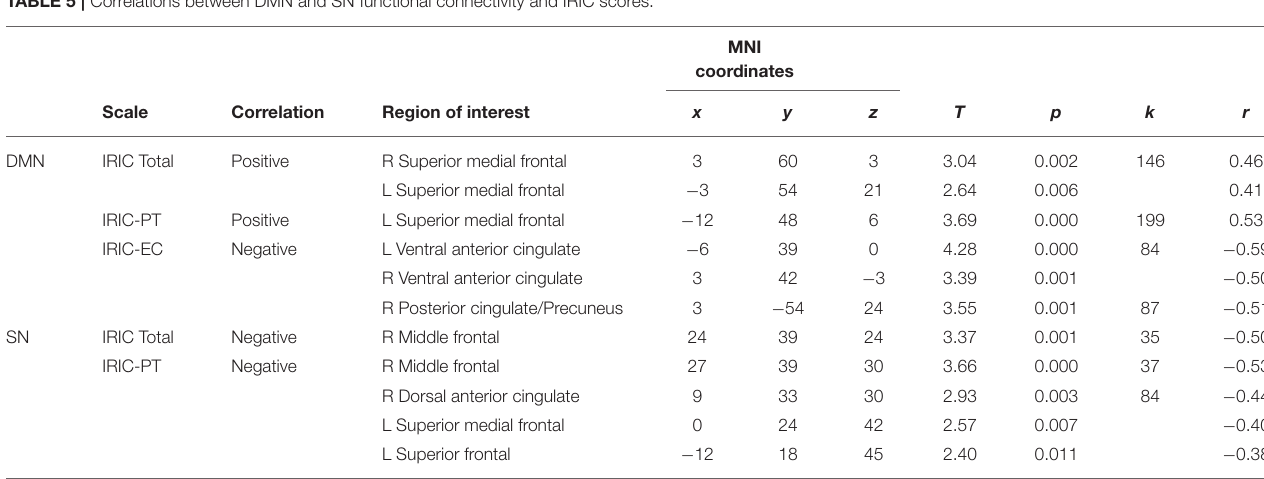
TABLE 5 | Correlations between DMN and SN functional connectivity and IRIC